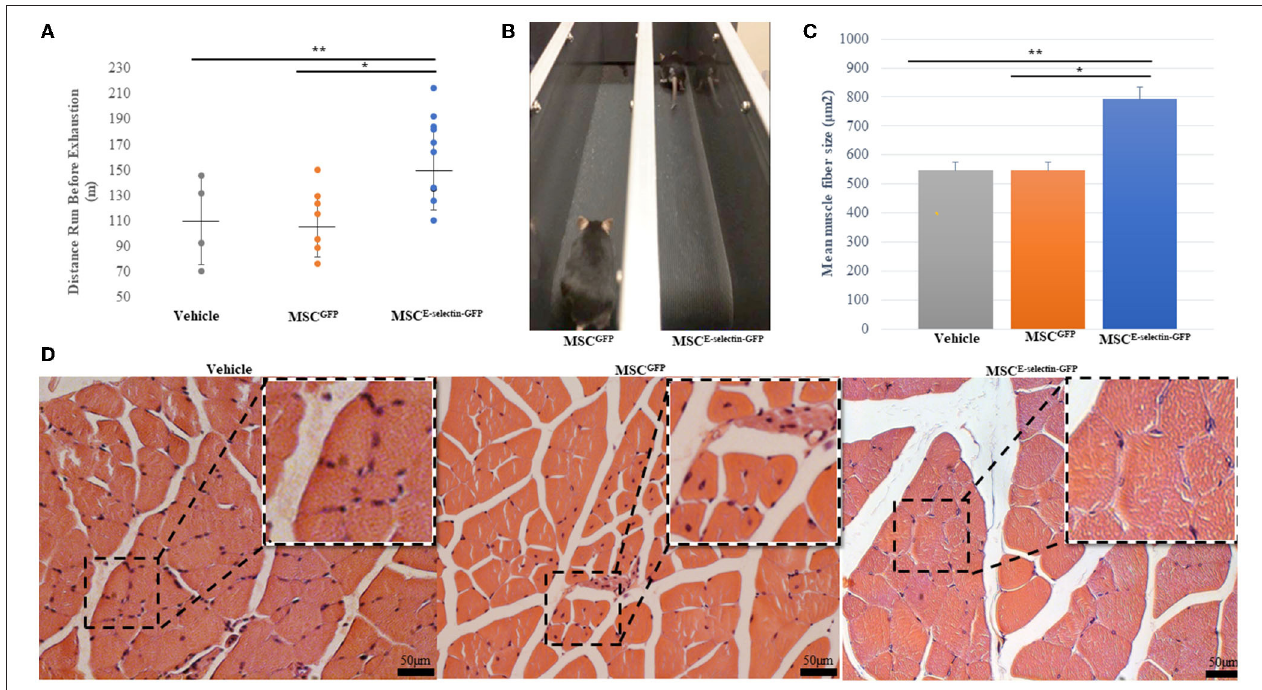
FIGURE 5 | Improved functional and pathologic recovery in ischemic muscles after treatment with MSC E − selectin − GFP . (A) Quantitative analysis of distance ran (m) prior to exhaustion in treatment groups (Vehicle = 4, MSC GFP = 7, MSC E − selectin − GFP = 10), ** P < 0.01 via ANOVA). (B) Representative image of MSC GFP vs. MSC E − selectin − GFP on treadmill. (C) Qualitative analysis of the mean myofiber size of the ischemic calf muscle, data are based on 5 section/sample/mouse ( µ m 2 , mean ± SD, ** P < 0.01 via ANOVA, * P < 0.05 post-hoc Tukey Simultaneous Tests for Differences of Means, Vehicle treatment n = 3, MSC GFP treatment n = 3, MSC E − selectin − GFP treatment n = 3). (D) Representative images of transverse H&E sections of ischemic calf muscle in Vehicle, MSC GFP , and MSC E − selectin − GFP